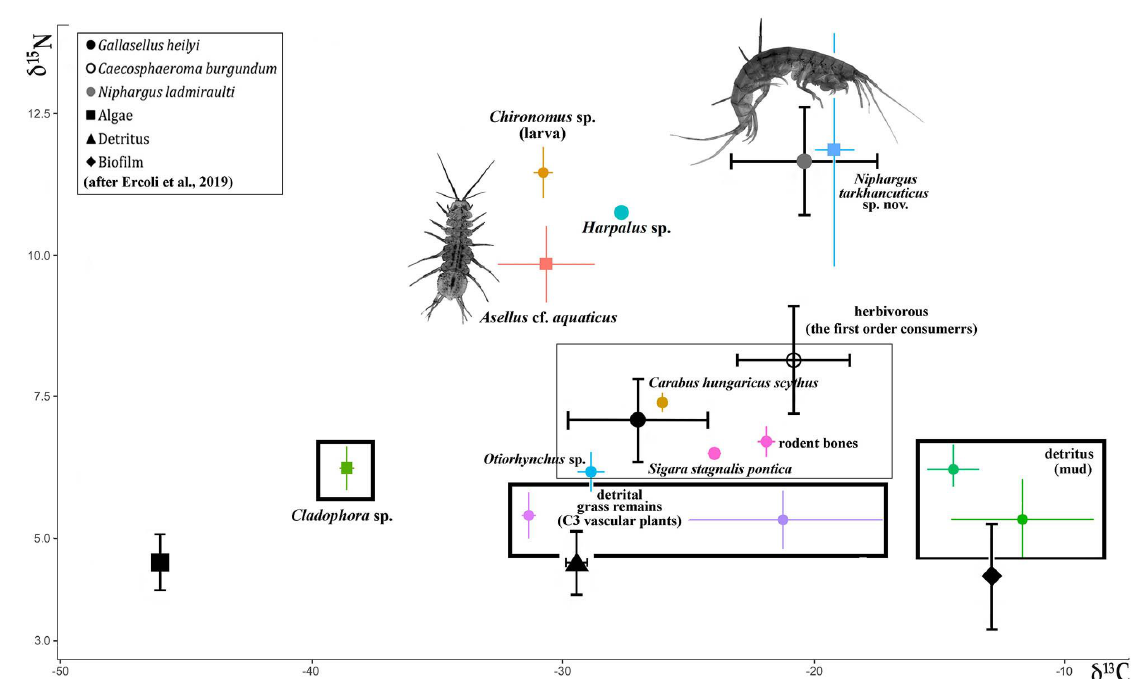
Figure 8. Bivariate plot of δ 13 C and δ 15 N isotope values (±S.D.) of organic matter and macrozooben- thos from wells in the Tarkhankut Upland (multicolored icons) in comparison with the δ 13 C/δ 15 N biplot (black/white icons) from stygobiotic habitats of the Roches-Prémarie-Andillé, France